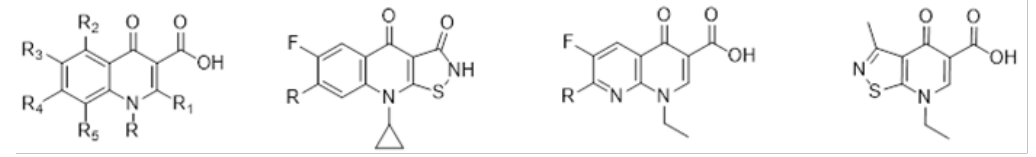
Figure 1. Core structures of the compounds used for the realization of the equations.